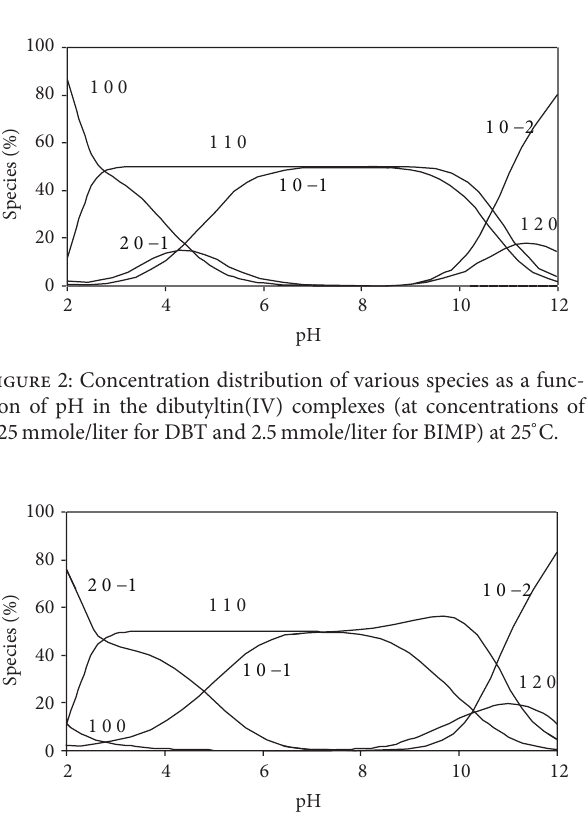
Figure 3: Concentration distribution of various species as a function of pH in the DPT-BIMP system (at concentrations of 1.25 mmole/liter for DPT and 2.5mmole/liter for BIMP) at 25 ∘